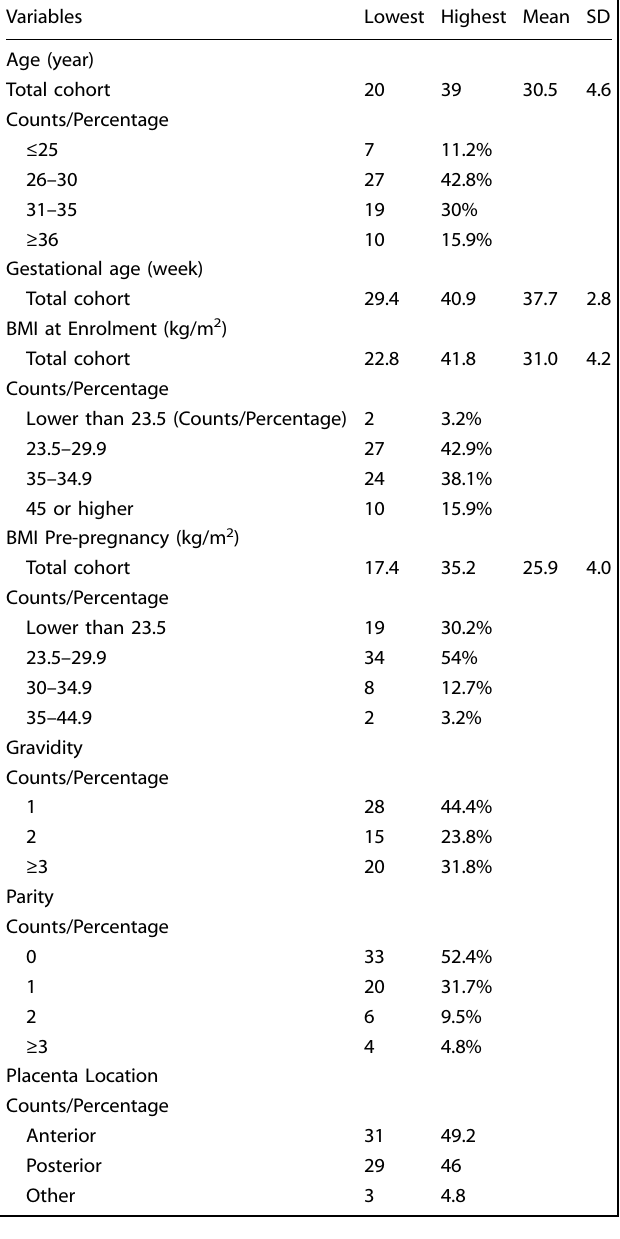
Table 1. Demographic and clinical characteristics of Phase 1 (clinic monitoring)